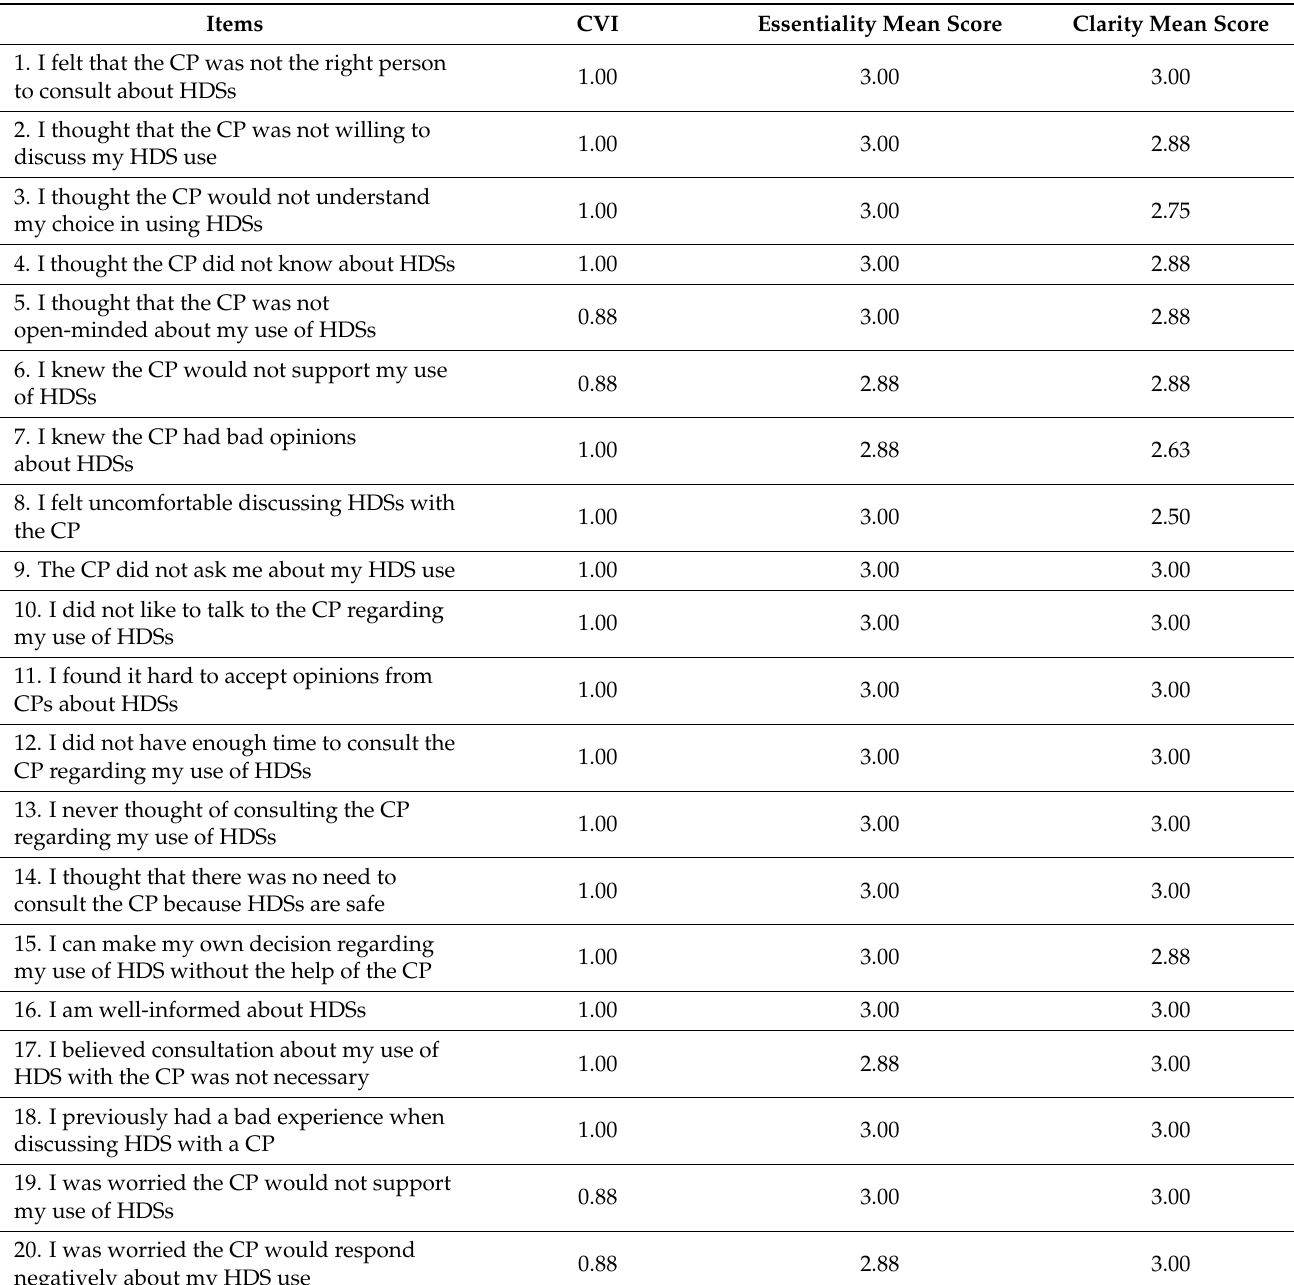
Table A4. Content Validity Index (CVI), and Mean “Essentiality” and “Clarity” Scores of “Reasons for Not Consulting CPs about HDS Use”